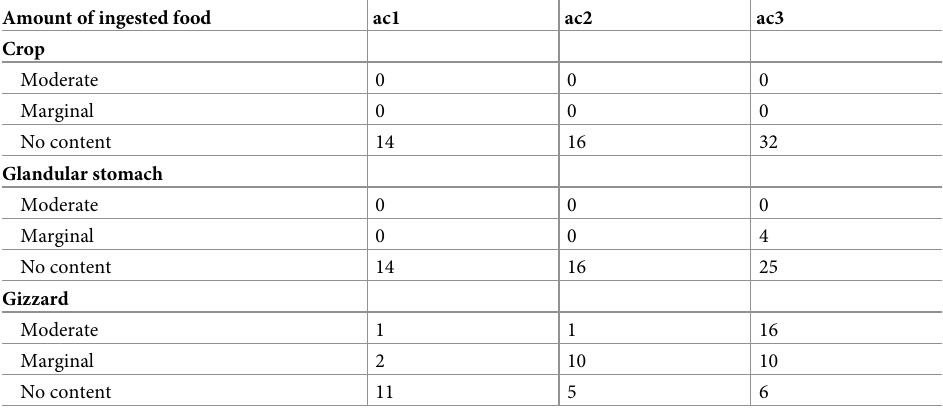
Table 3. Amount of ingested food in the gastric tract finding during necropsy. Amount of ingested food ac1 ac2 ac3 Moderate